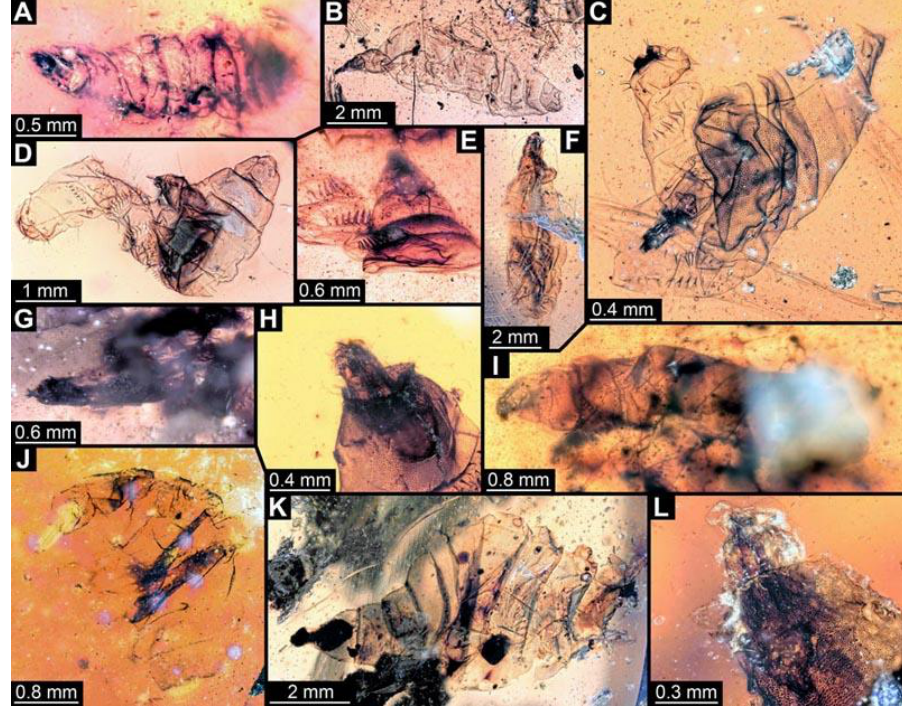
Figure 13. Several fossil larvae. ( A ). PED 0822. ( B ). PED 0861. ( C ). PED 1007-3. ( D ). PED 0966. ( E ). PED 0976-1. ( F ). PED 1010. ( G ). PED 0976-2. ( H ). PED 1007-1. ( I ). PED 1129. ( J ). PED 1192. ( K ). PED 1405. ( L ). PED 1007-2.